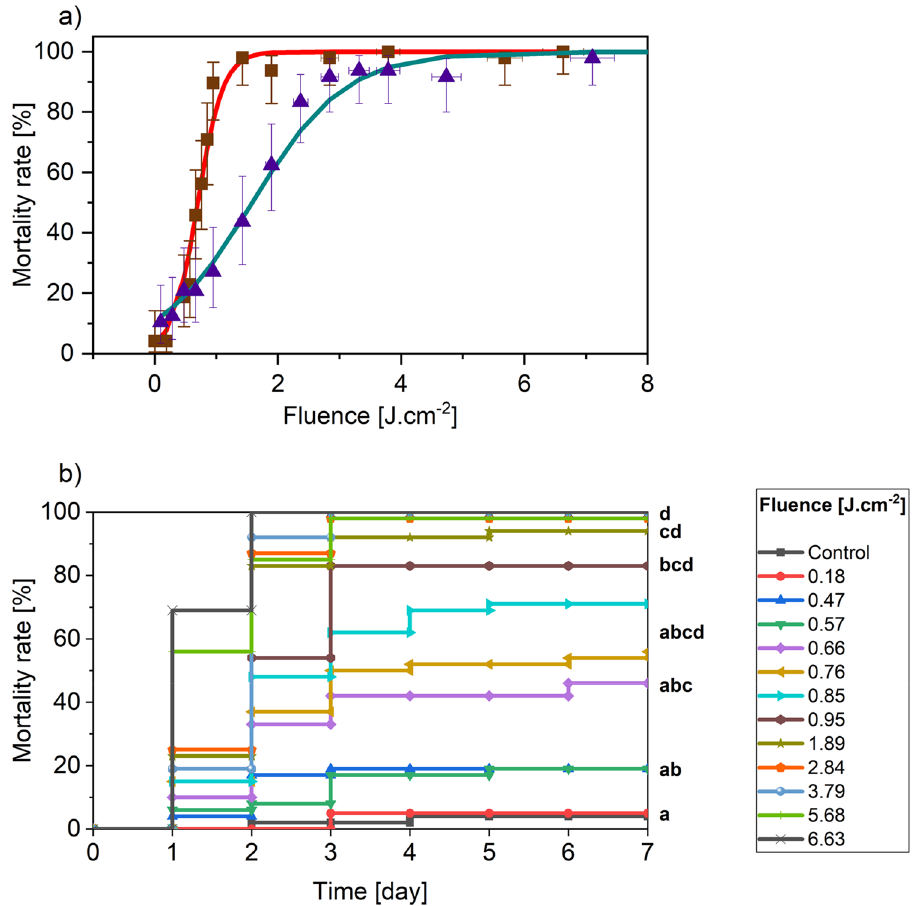
Figure 3. ( a ) Mortality rates as a function of the fluence using a 10.6 µm laser at Day + 1 (Blue triangles) and Day + 7 (Red squares). Control samples showed that 96% or more aphids survived. Error bars are plus and minus exact binomial 95% confidence intervals. The gray and red solid lines are logistic regressions obtained at Day + 1 and Day + 7 respectively. Statistical tests are available in Supplementary Table S4. ( b ) Evolution of the mortality rate over seven days at different fluences using the CO 2 laser on synchronized N1 A. pisum LL01 nymphs (green aphids). Letters in the right refer to the results of the 95% confidence interval GLM Gaussian